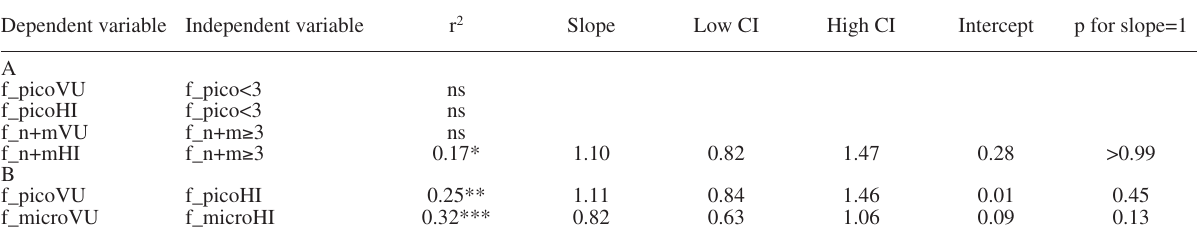
Table 6. – Parameters of the standard major axis regression lines (A) between the proportions of picophytoplankton and nano + microphyto- plankton estimated by size-fractionated filtration (f_pico<3 and f_n+m ≥ 3, respectively), and the corresponding estimates using the Vidussi et al. (2001) - Uitz et al. (2006) diagnostic pigment method (f_picoVU and f_n+mVU, respectively) and the Hirata et al. (2011) total Chl a -based method (f_picoHI and f_n+mHI, respectively); and B, between the proportions of picophytoplankton and microphytoplankton estimated by the VU and HI methods (f_picoVU vs. f_picoHI and f_microVU vs. f_microHI). “Low CI” and “High CI” are the 95% confidence limits. Probability values of the test for slope=1 are based on the F-statistic. ns: non-significant, * p<0.005, ** p<0.001, ***